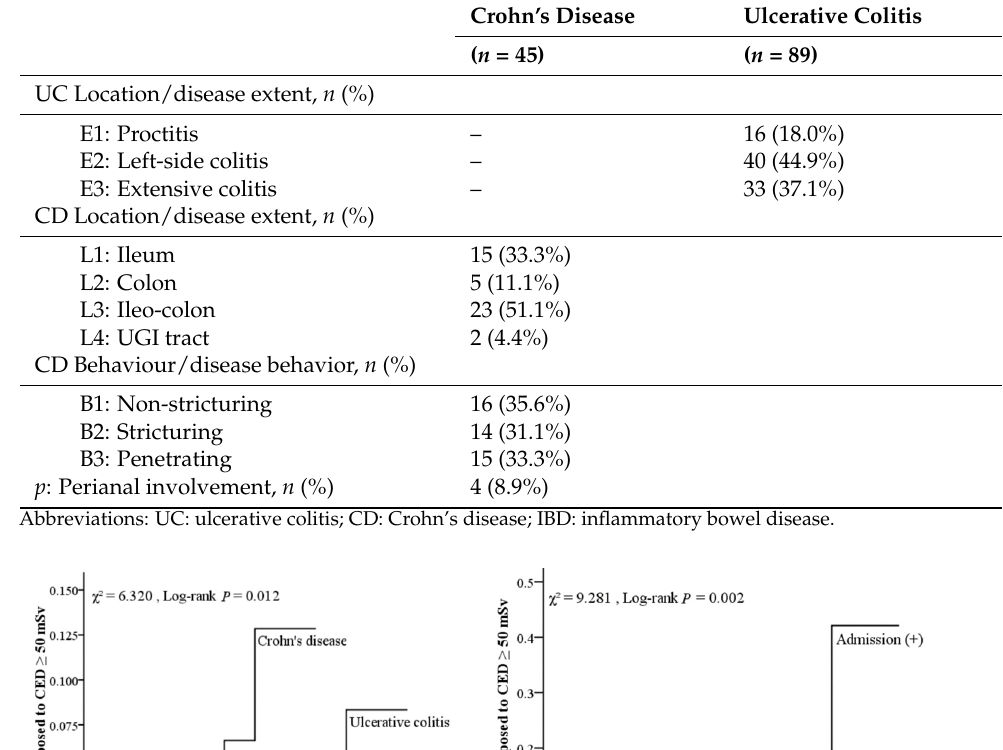
Table 3. Location and extent of involvement of IBD.